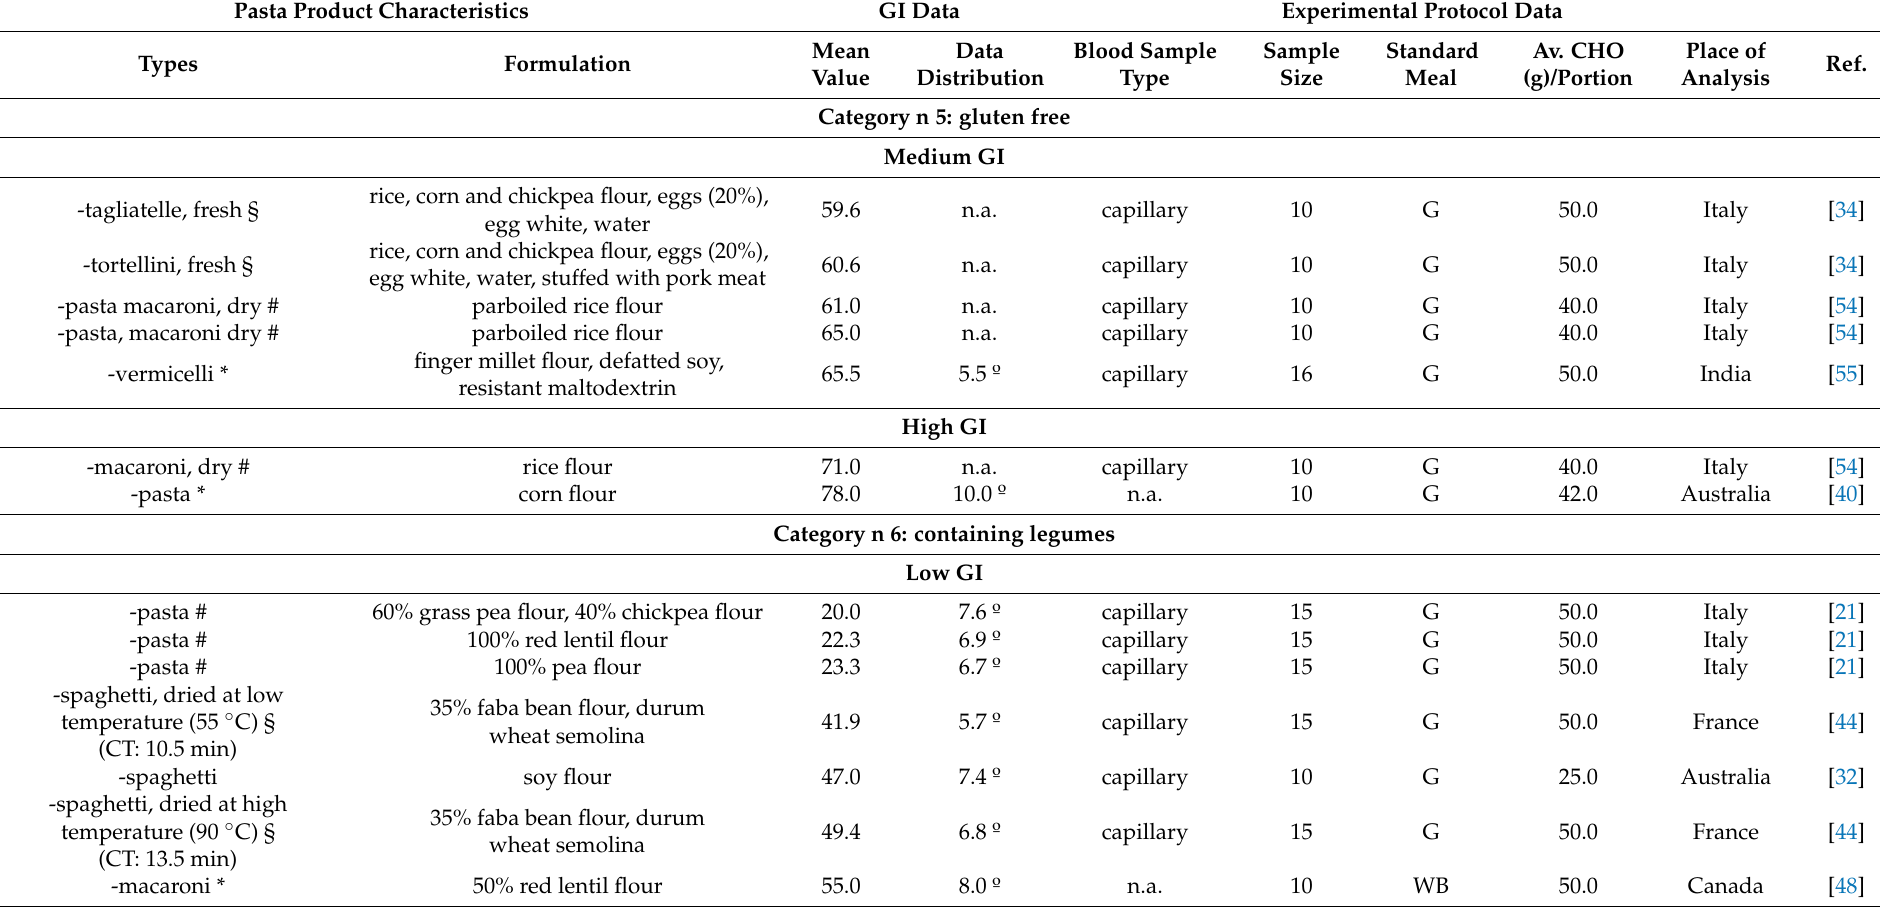
Data Distribution